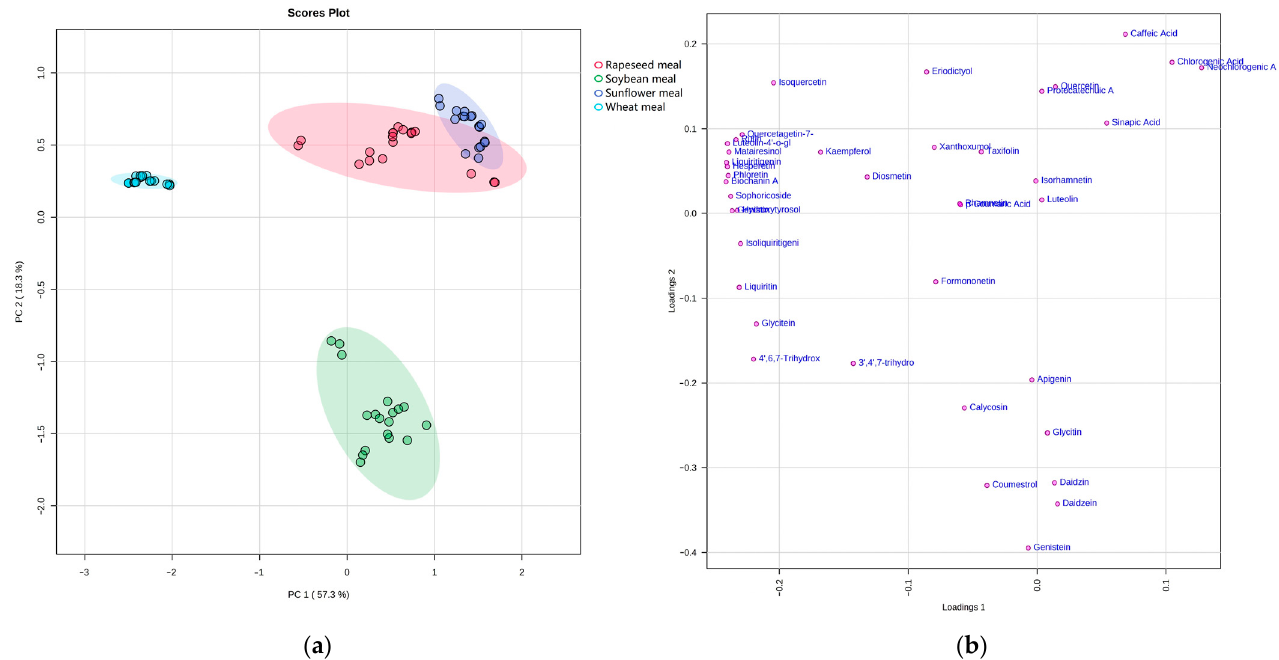
Figure 3. Score plot of principal component analysis (PCA) of ( a ) LC-MS-based normalized data and ( b ) Loading plot of phytoestrogens. ( b ) Loading plot of